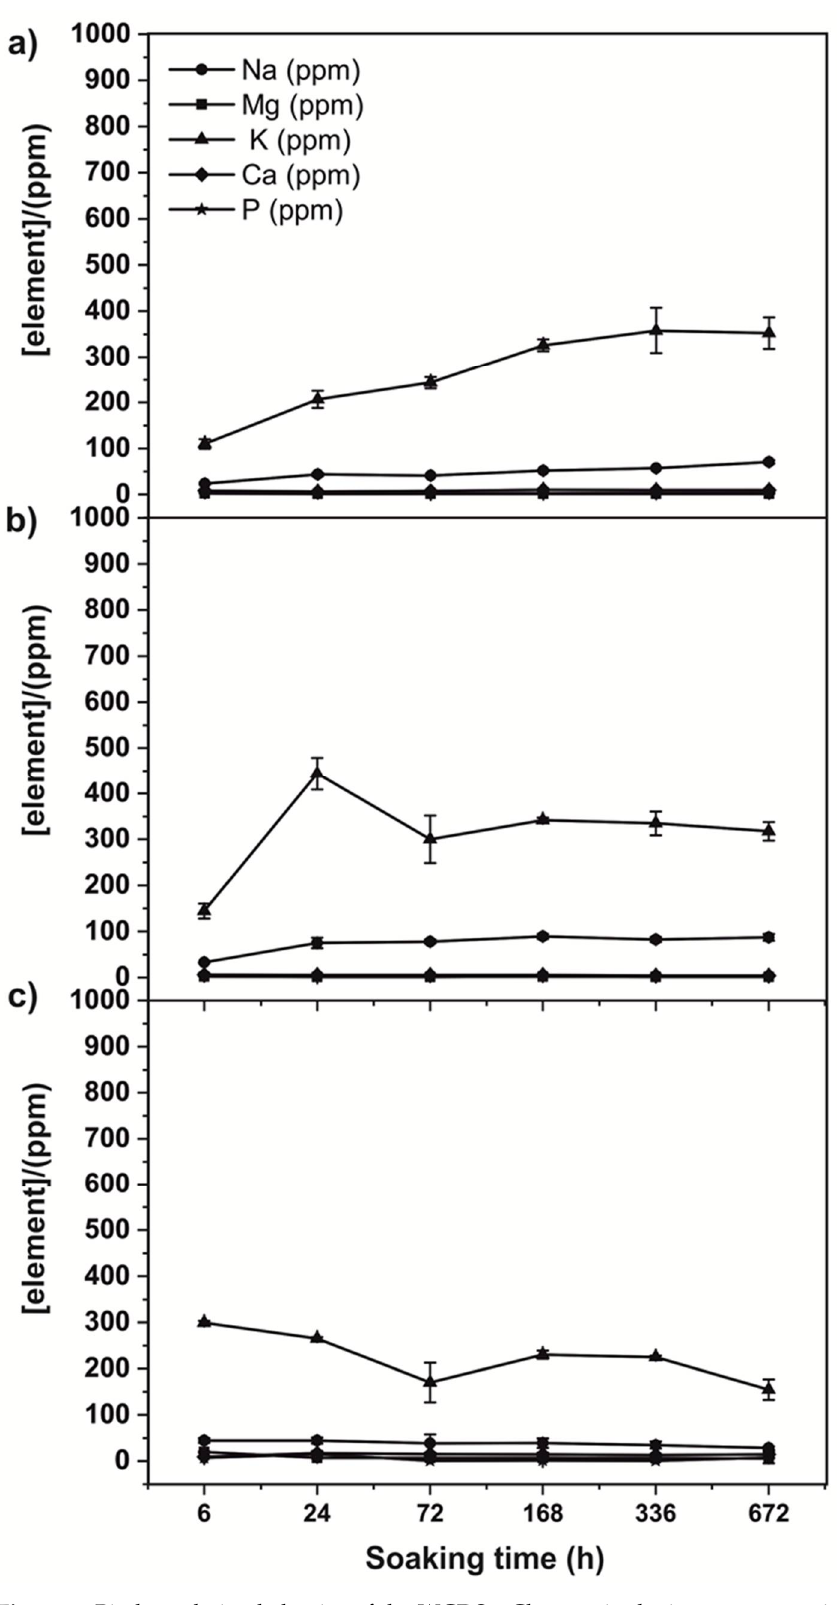
Figure 6. Biodegradation behavior of the WCDSs: Changes in the ions concentration vs. soaking